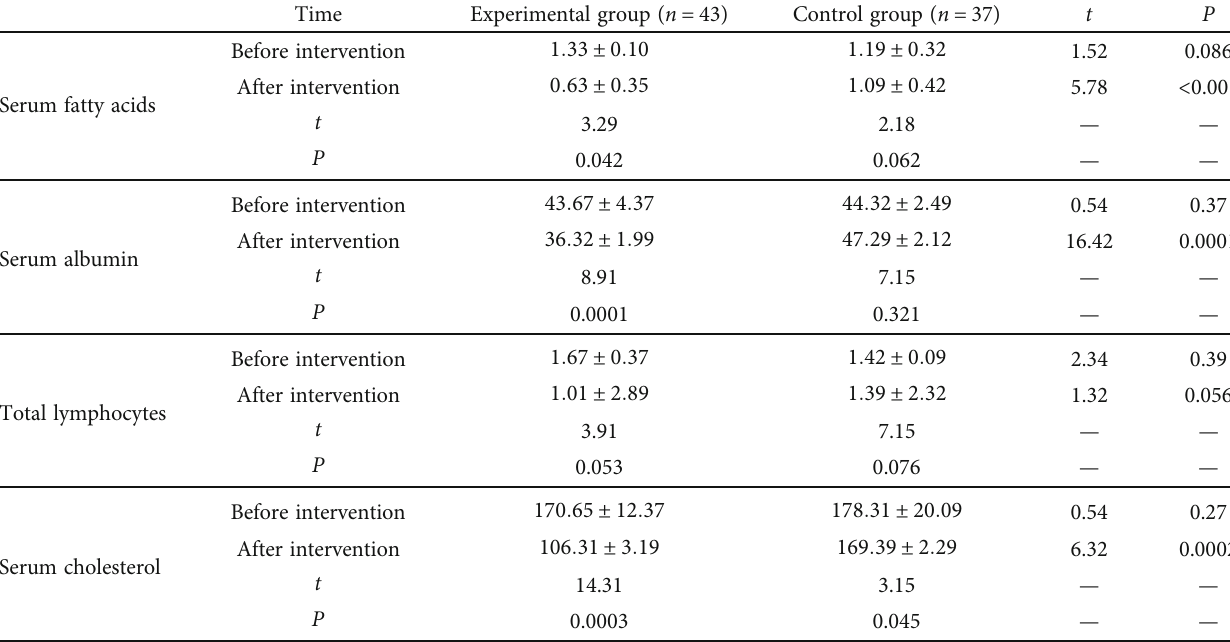
Table 3: Comparison of nutritional status between the two groups before and after intervention (points, (cid:1) x ± s ).